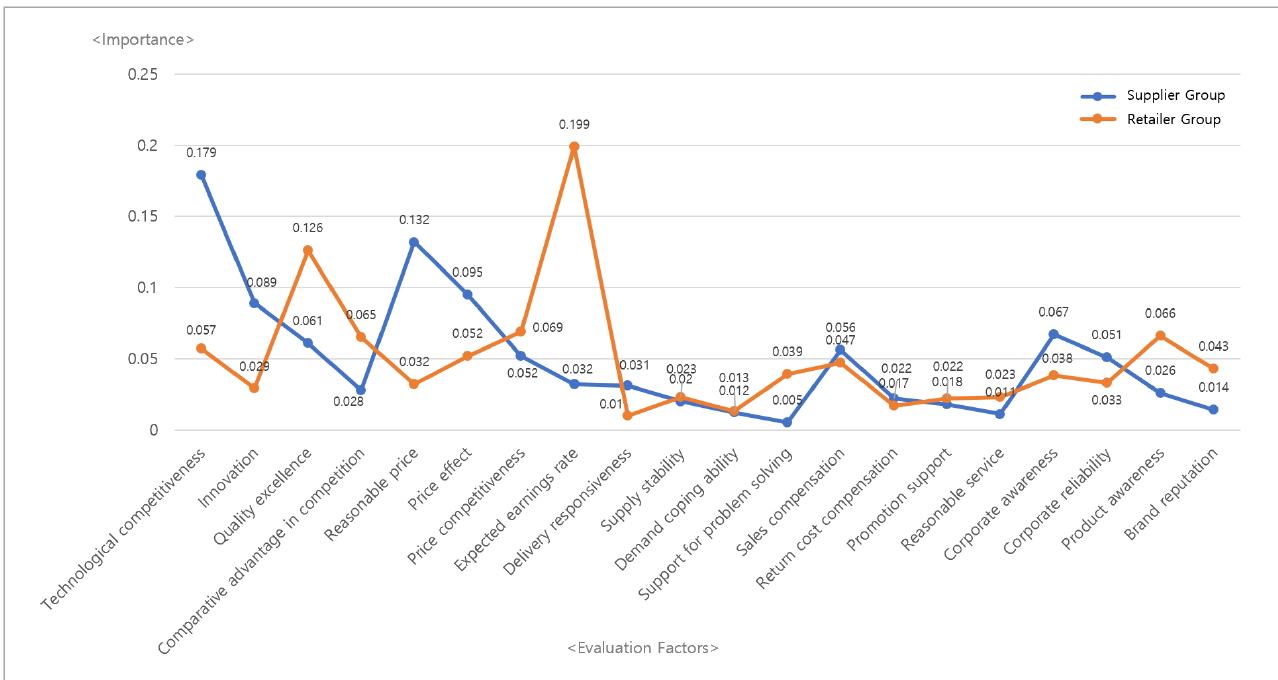
Table 6. Comparison analysis result on evaluation factors.